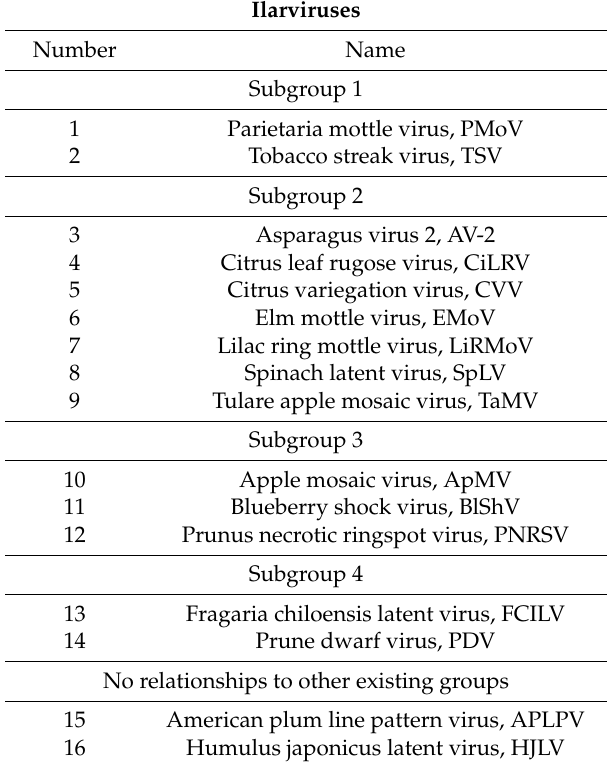
Table 1. Taxonomy classification of Ilarviruses based on information from Bujarski et al. [1].